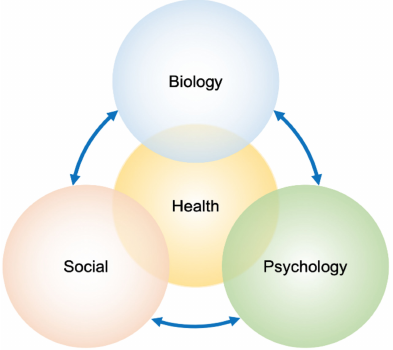
Figure 1. The key characteristics of the biopsychosocial approach with three different aspects during patient care: the biological component of the disease as symptoms, the psychological impact of the disease, and the patient’s social context. Every component in a chronic disorder can affect the patient’s